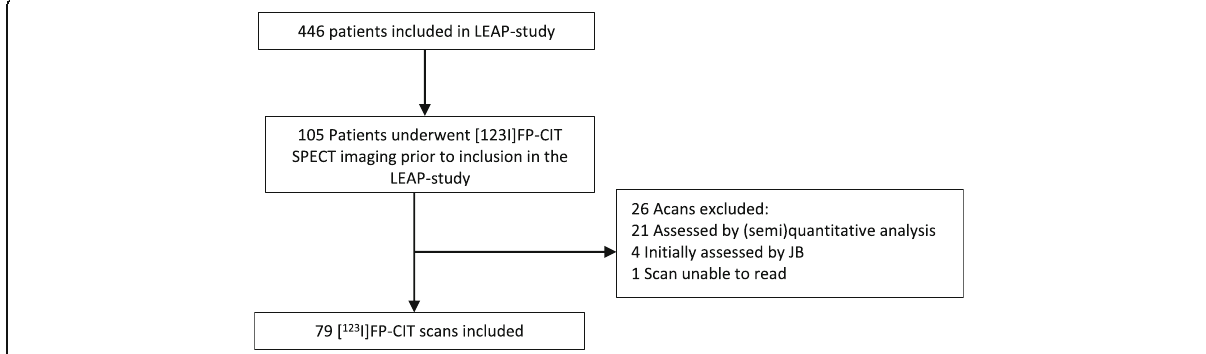
Fig. 3 Flowchart of included DAT SPECT scans. LEAP, Levodopa in EArly Parkinson ’ s disease; DAT, dopamine transporter; SPECT, single-photon emission; computed tomography; JB, J. Booij